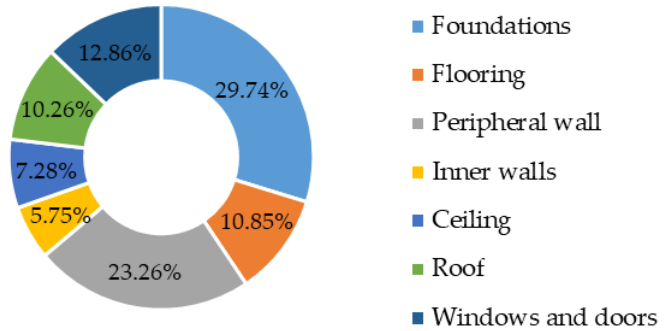
3.2.3. Impact on Photochemical Oxidation